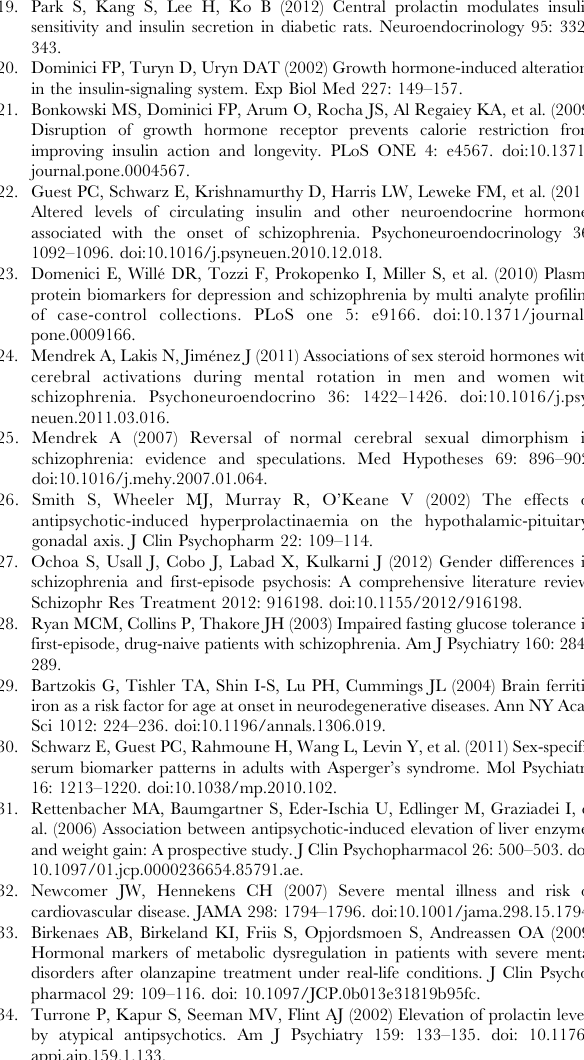
File S1 Table S1-Table S6. Table S1. Major depressive disorder (MDD) patient demographics. Table S2. Bipolar disorder (BPD) patient demographics. Table S3. List of 95 analytes measured using the HumanMAP H multiplex immunoassay platform and included in the comparison across all cohorts. Table S4. Summary of sex-specific changes in analyte levels within